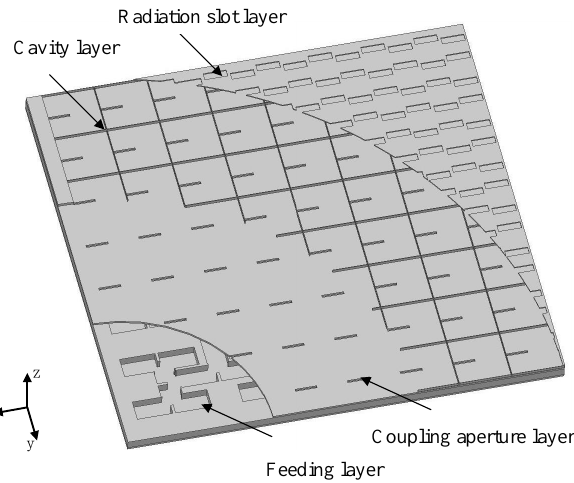
Figure 1. Overall configuration of the proposed waveguide-based multi-layered slotted cavity antenna array, which consists of four parallel copper plates: the radiation slot layer (“Layer1”), the cavity layer (“Layer2”), the coupling aperture layer (“Layer3”), and the feeding layer (“Layer4”).